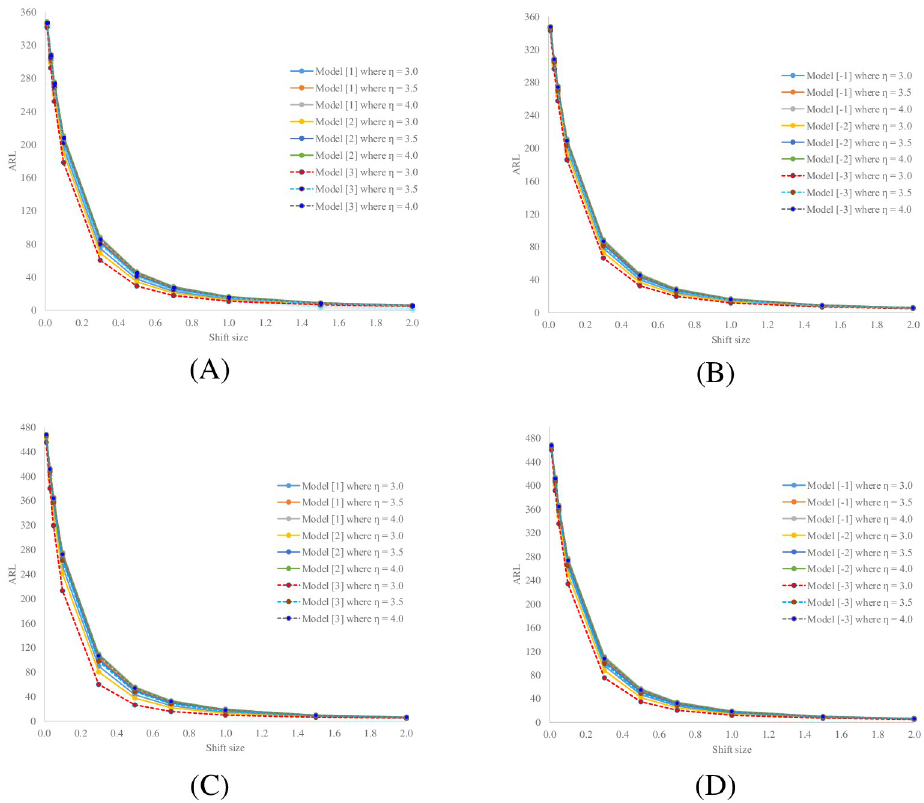
Fig 1. Comparative performances of the analytical and numerical IEs for determining ARL 1 for detecting shifts in the mean of a long-memory process on a CUSUM control chart given reference value ( η ) = 3.0, 3.5 and 4.0. (A) Models [1] to [3] for ARL 0 = 370, (B) models [–1] to [–3] for ARL 0 = 370, (C) models [1] to [3] for ARL 0 = 500, and (D) models [–1] to [–3] for ARL 0 = 500.